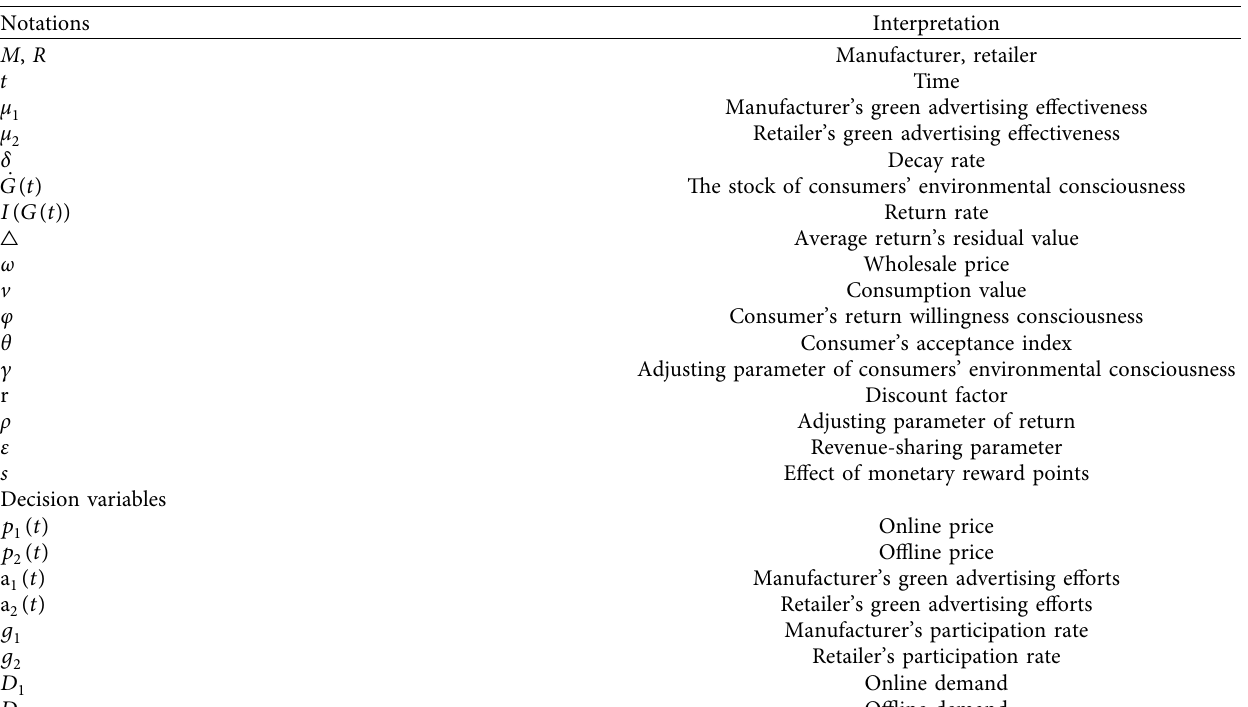
Table 3: Summarized